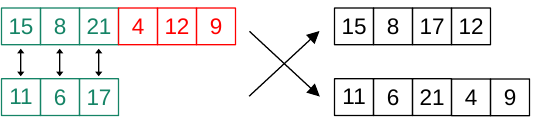
Figure 5. During crossover, the child vector components are uniformly sampled from the matching parts of parent vectors (shown in green), and the extra components of the longer parent (shown in red) are assigned independently and randomly to the